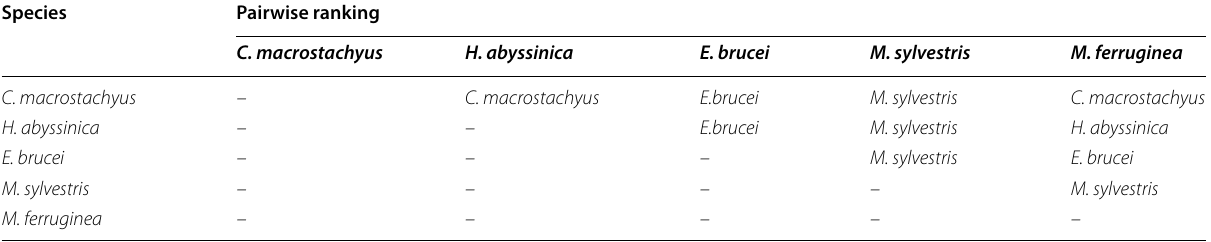
Table 7 Pairwise ranking of tree/shrub species nominated for litter study in the homegarden agroforestry systems of the study sites, southwestern and southern Ethiopia Species Pairwise ranking